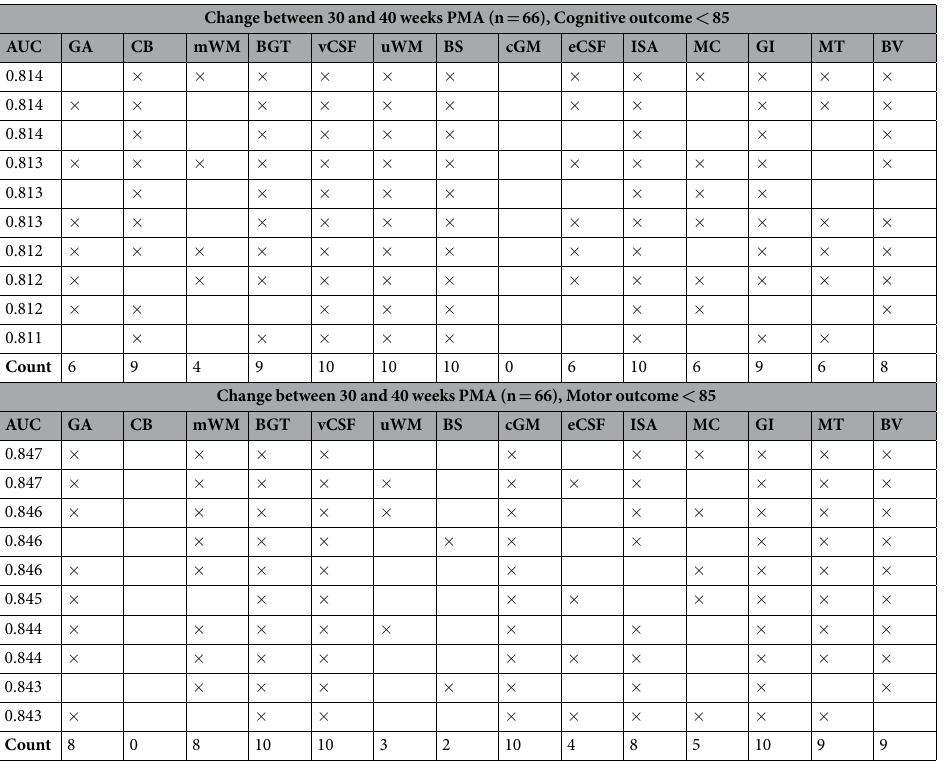
Table 4. AUCs for the 10 best performing combinations of descriptors for cognitive (top) and motor (bottom) outcome based on the change between 30 and 40 weeks PMA. GA: gestational age, CB: cerebellum volume, mWM: myelinated white matter volume, BGT: basal ganglia and thalami volume, vCSF: ventricular cerebrospinal fluid volume, uWM: unmyelinated white matter volume, BS: brain stem volume, cGM: cortical grey matter volume, eCSF: extracerebral cerebrospinal fluid volume, ISA: inner cortical surface area, MC: global mean curvature, GI: gyrification index, MT: median cortical thickness, BV: brain volume. The bottom row shows in how many of the combinations each descriptor is